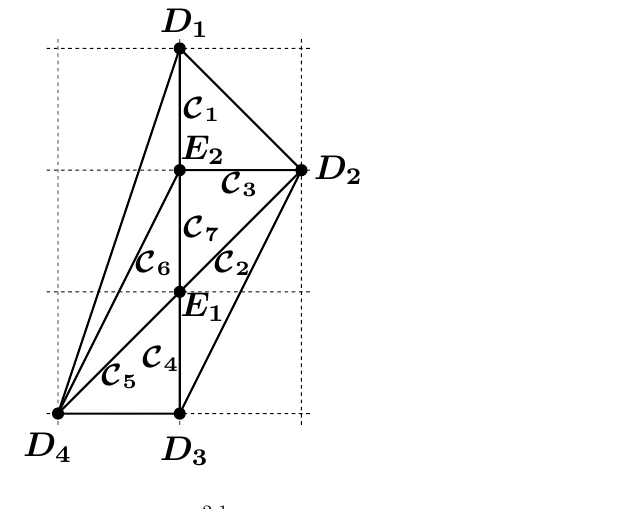
Figure 7 . The unique crepant resolution of the E 12 ; 1 singularity. This admits a vertical reduction. The compact curves the toric diagram (for example,